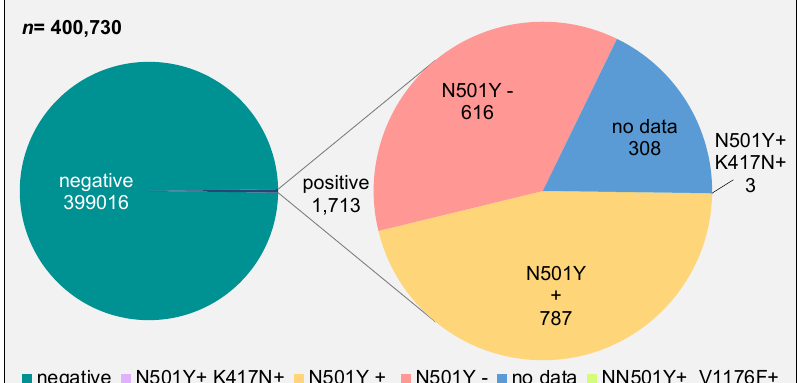
Figure 2. PCR results for VOC key mutations. PCR melting curve analysis was conducted on all SARS CoV-2 positive samples. 0 samples tested positive for mutation V1176F.